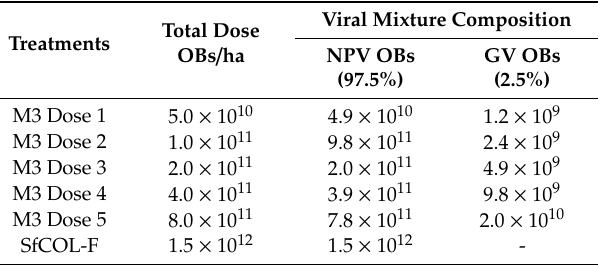
Table 1. Treatments evaluated in the greenhouse trial against S. frugiperda .